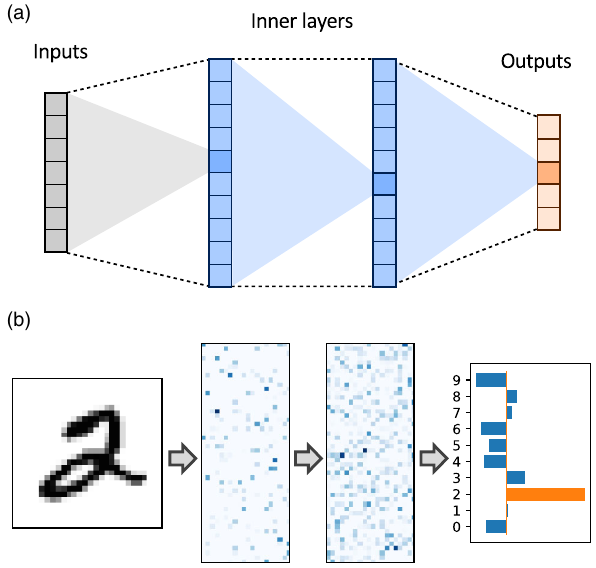
FIG. 3. MNIST digit classification. Error rate for neural- network inference as a function of photons per MAC n MAC ¼ ð hc= λ Þ n (equivalently energy E ; here, λ ¼ 1 . 55 μ MAC MAC